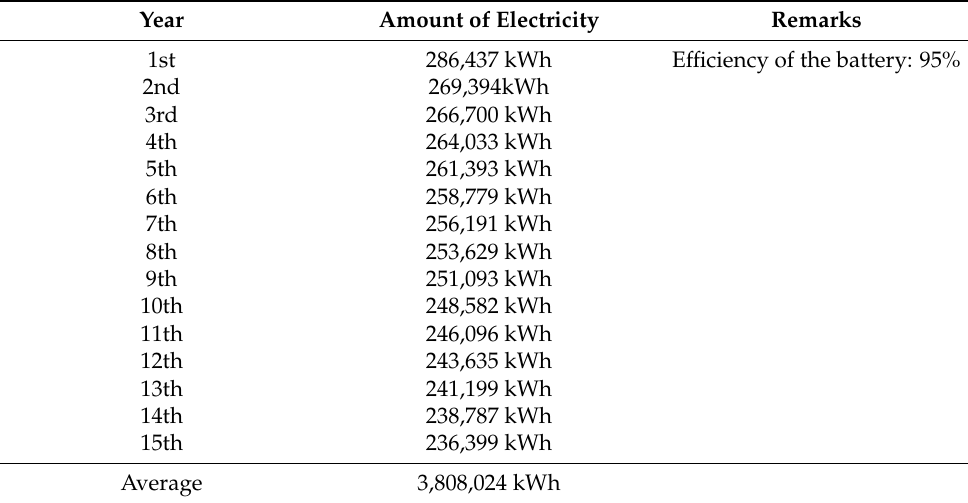
Table 48. The annual amount of electricity to be stored in the ESS